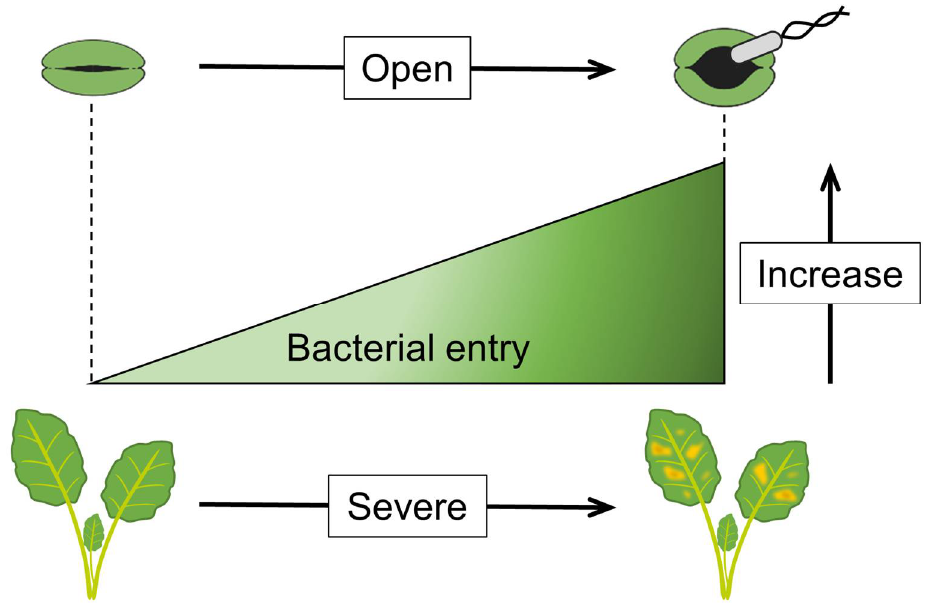
Figure 3. The correlations among stomatal opening width, bacterial entry, and disease symptoms. As stomata is open, bacterial entry increases. As the initial bacterial entry increases, severe disease symptoms